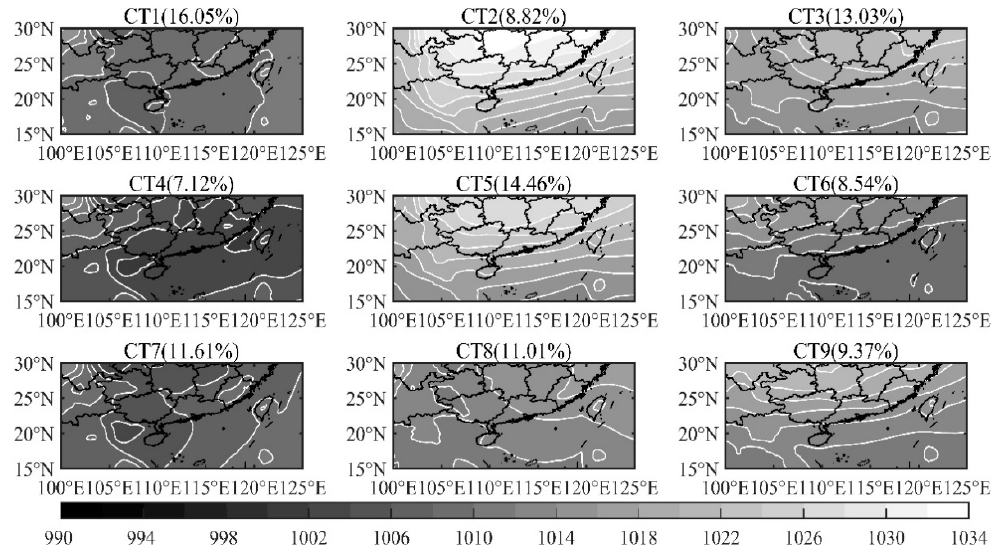
Figure 2. The mean sea level pressure and frequency of different circulation types from 2013 to 2017 in Pearl River Delta.